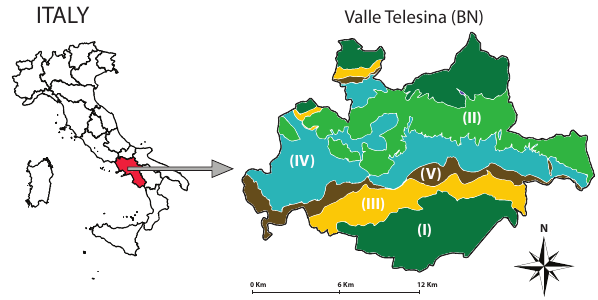
Figure 2. Map of Valle Telesina and its main landscape systems: (I) mountains, (II) hills, (III) pediment plain, (IV) ancient fluvial terraces, (V) alluvial